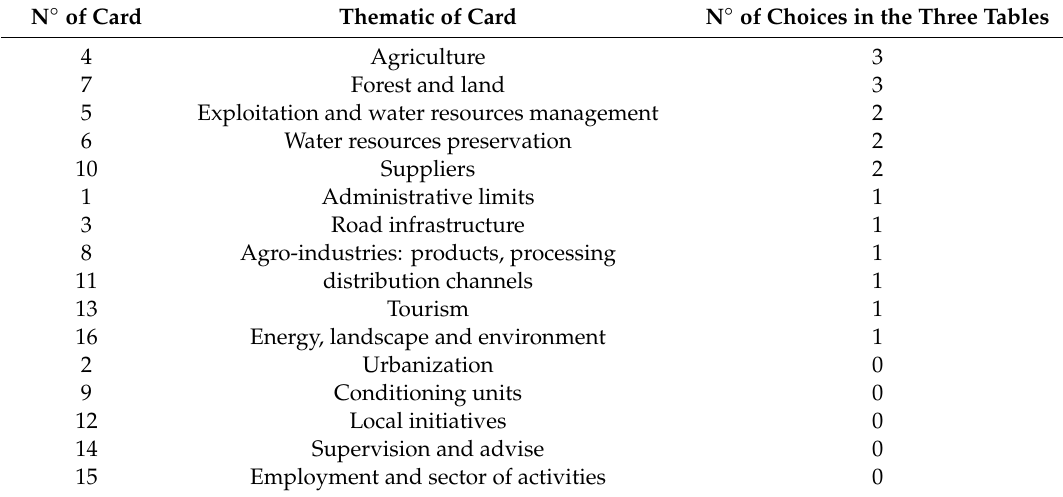
Table 2. The playing cards choices by